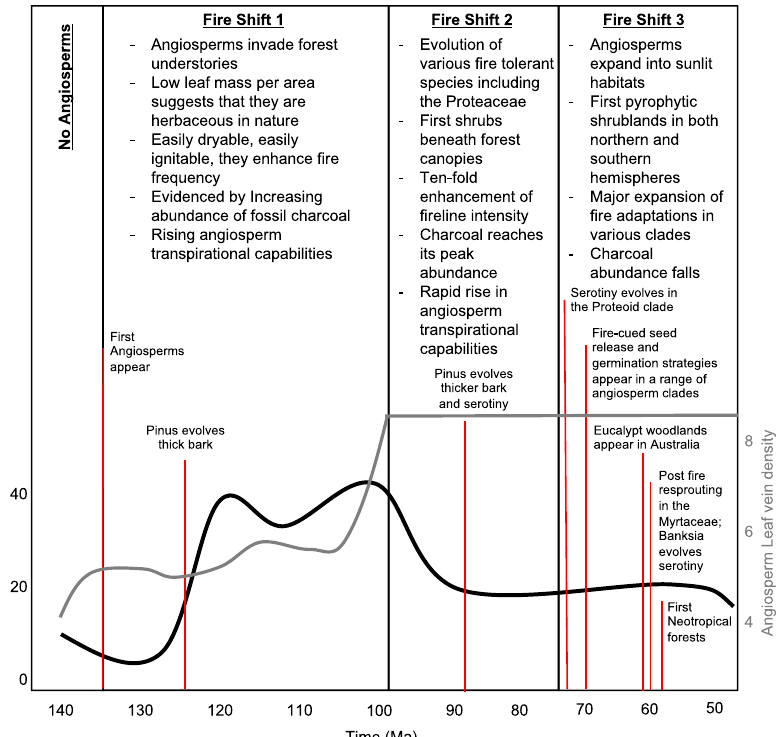
Fig. 2 Cretaceous plant innovations and their linkage to fi re regimes. We describe three fi re shifts-that we propose drive changes in fi re suppression of biomass between 140 and 50 Ma. These shifts are informed by the key evolutionary changes and innovations listed in each box that are used to determine the fi re suppression ratio in the COPSE model (see Fig. 3a). Speci fi c events are marked by labelled red lines. This information is set against the abundance of inertinite (fossil charcoal) found in coals (black line) (data from ref. 47 ) and changes in angiosperm leaf vein density (grey line) (data from ref. 54 ) is shown highlighting the transition to plants with high transpiration